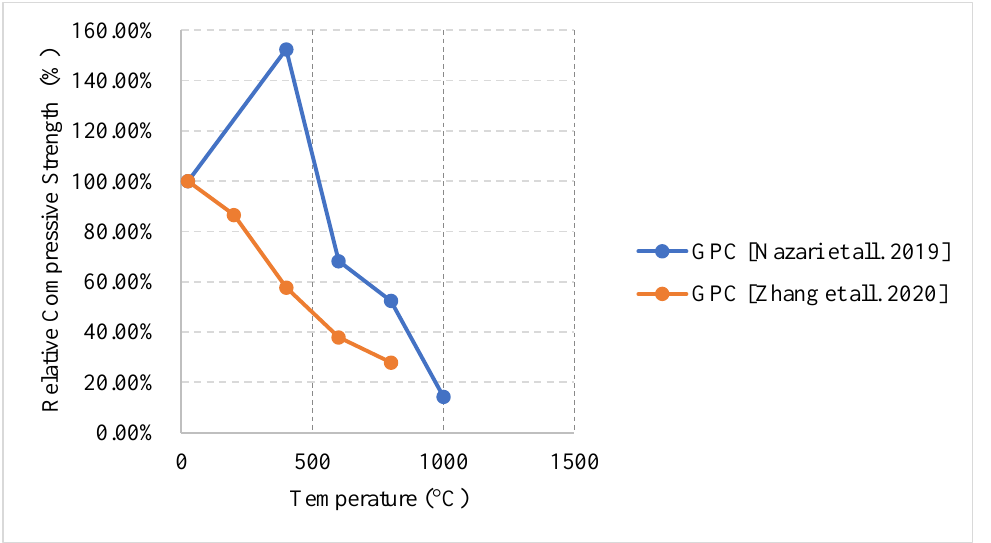
Figure 39. Relative compressive strength of water-cooled GPC with different constituents [44,117].